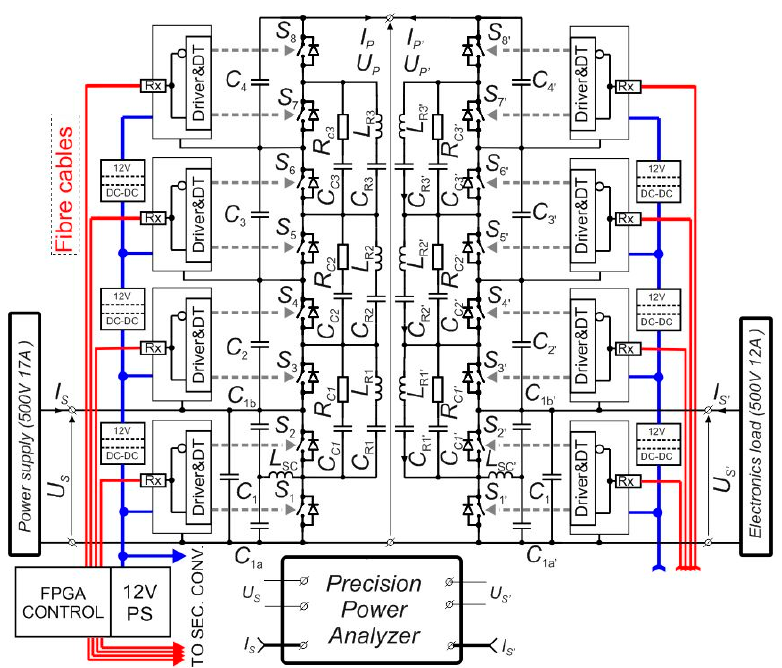
Figure Figure 7. Schematic of the MRSCC laboratory back-to-back setup with modification applied ( L SC + C Ck R Ck ).